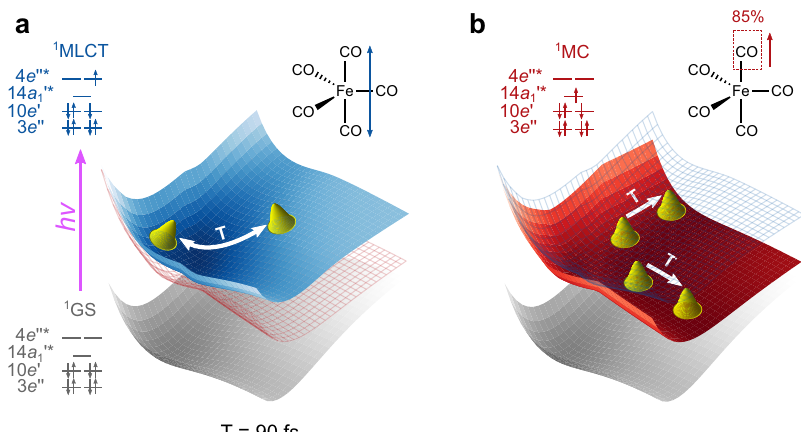
Fig. 3 Schematic representation of the oscillation in the metal-to-ligand charge-transfer (MLCT) state and the periodic release of predominantly axial CO ligands in a metal-centered (MC) state. a The oscillation of the two axial COs in the bound MLCT state occurs with a period of ~90 fs. b This leads to the periodic crossover to the dissociative MC states at the same frequency, which in turn produces periodic bursts of CO dissociation having a time lag of 90 fs. Orbital con fi gurations of the ground state and speci fi c MLCT and MC states are